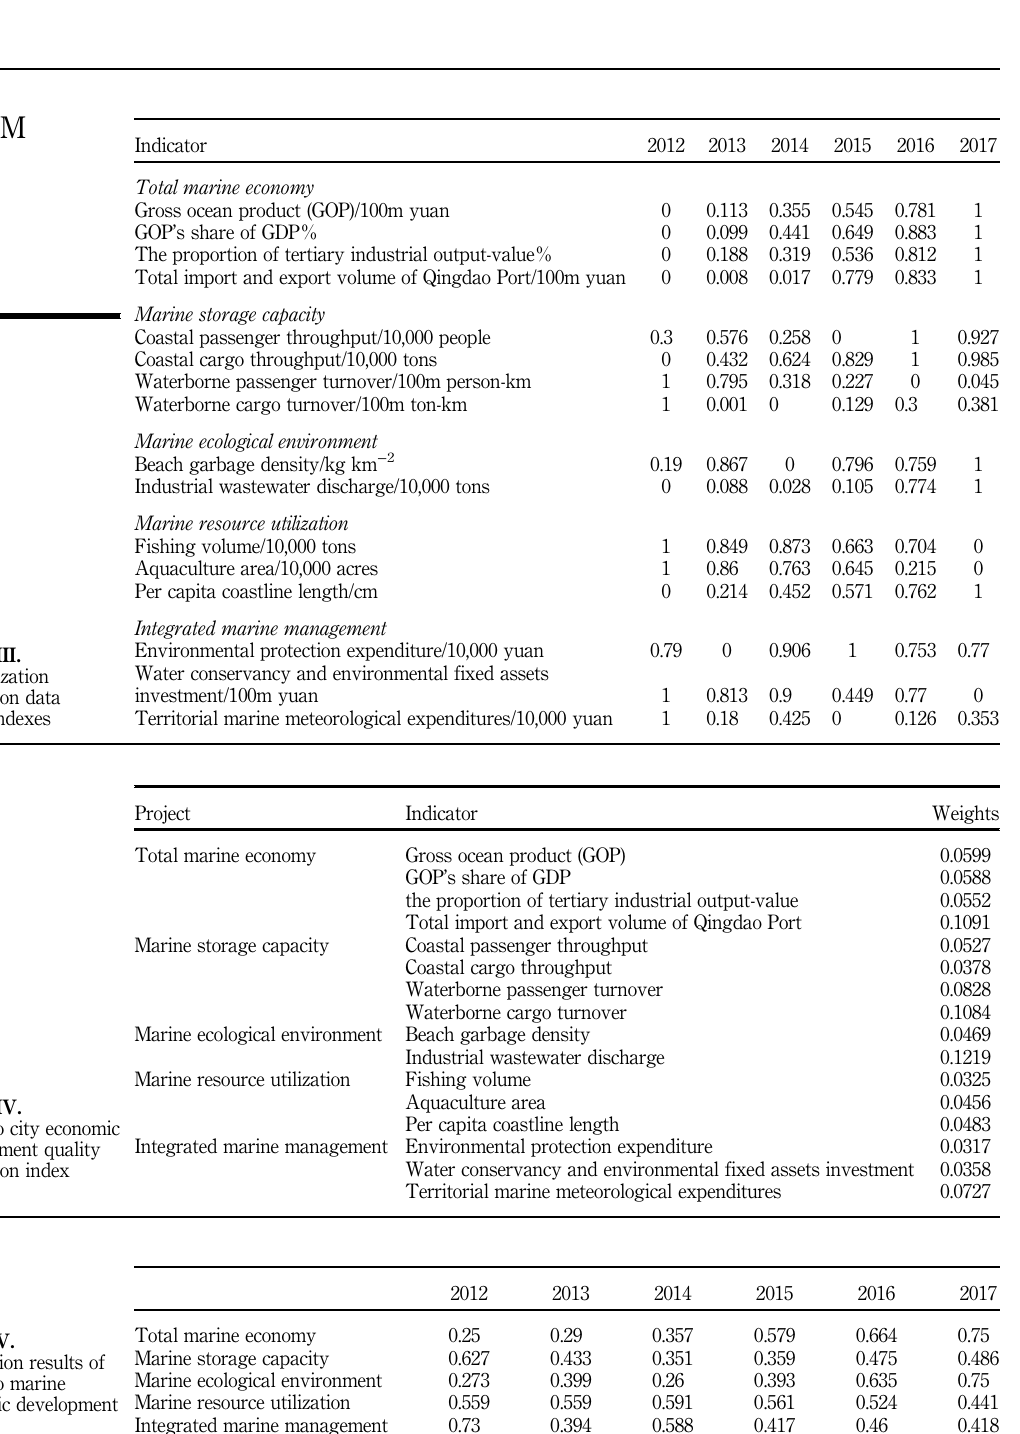
Table V. Evaluation results of Qingdao marine economic development